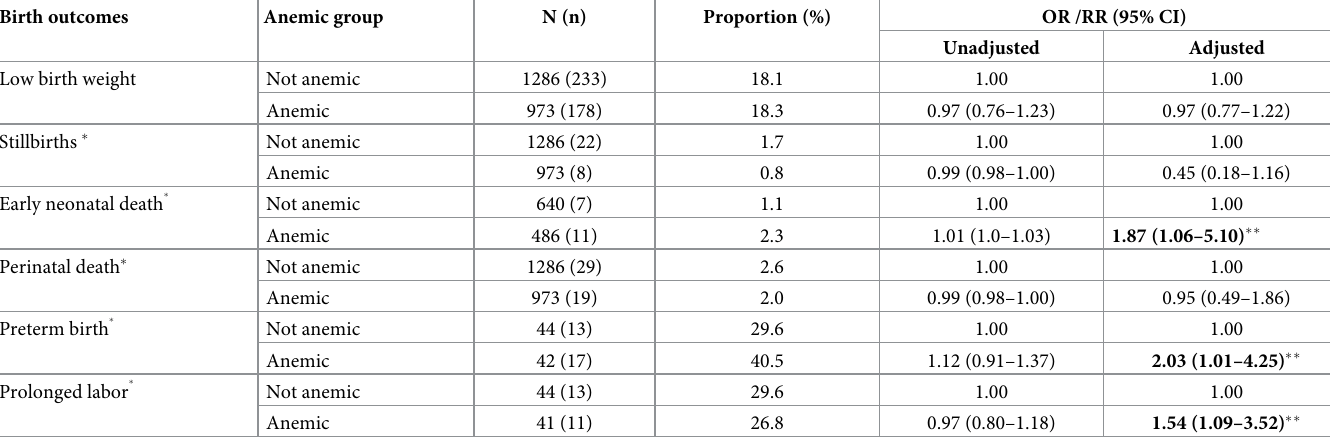
Table 4. Unadjusted and adjusted relation between maternal anemia and adverse birth outcomes,